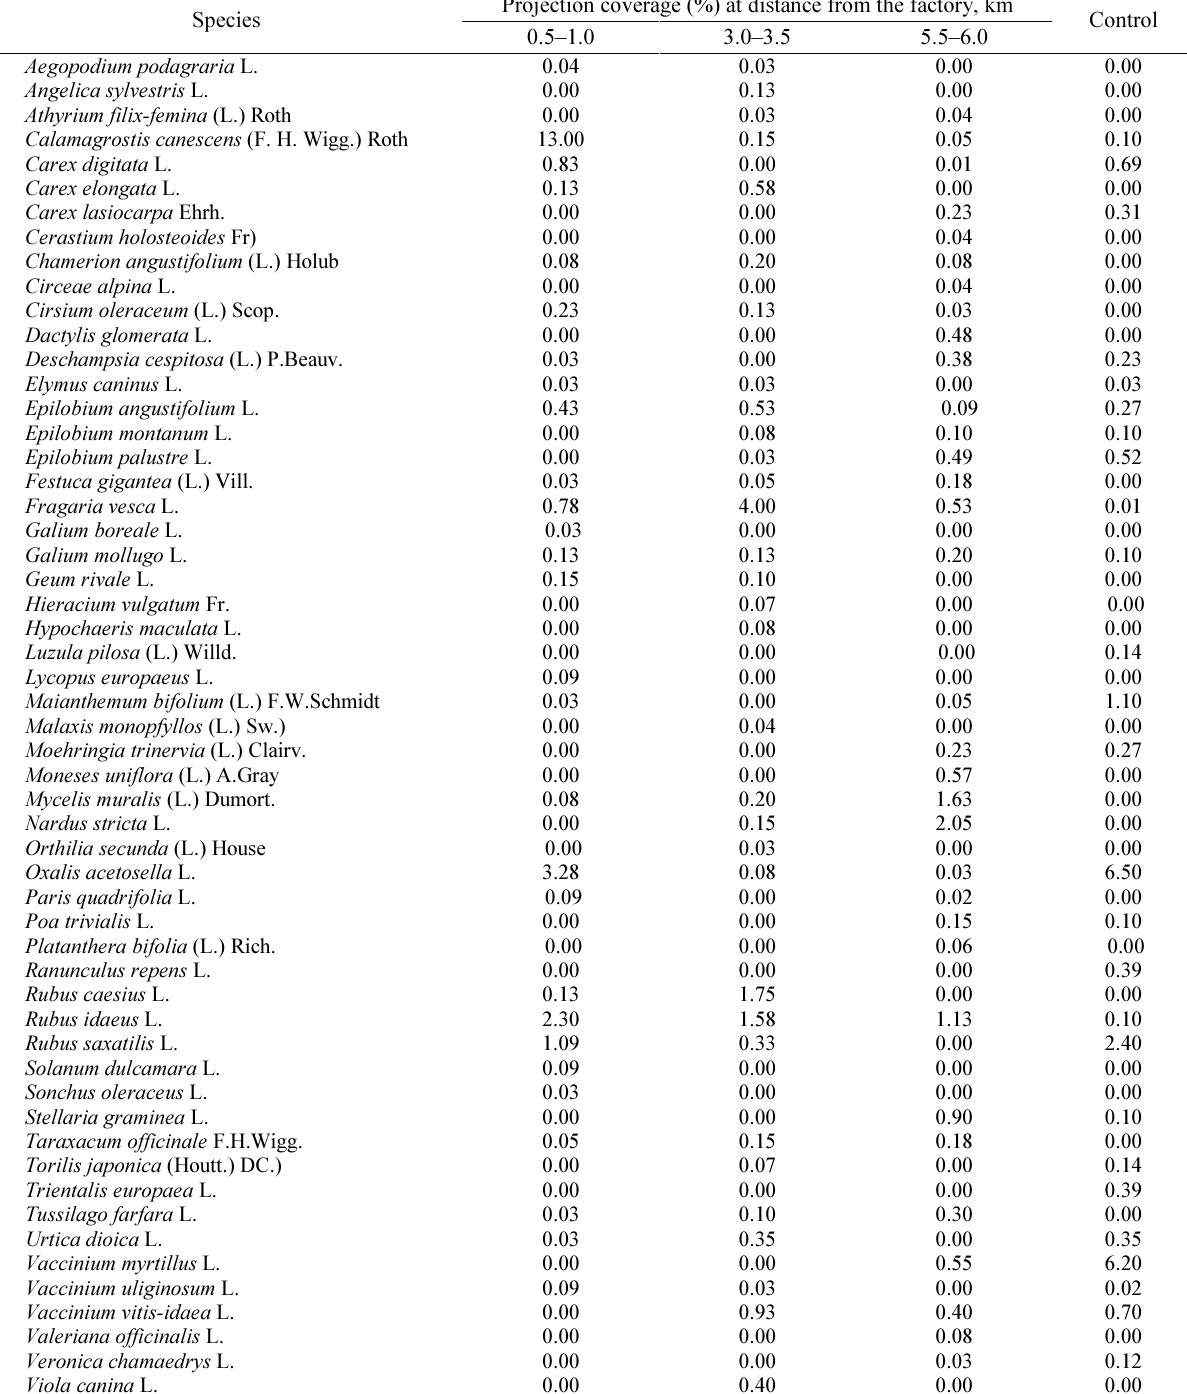
Table 3. Herbaceous plant species and their projection coverage (%) at different distances from the pollution source and control forest stand (an average data from 36 vegetation sample quadrates at each distance and control) Projection coverage (%) at distance from the factory, km